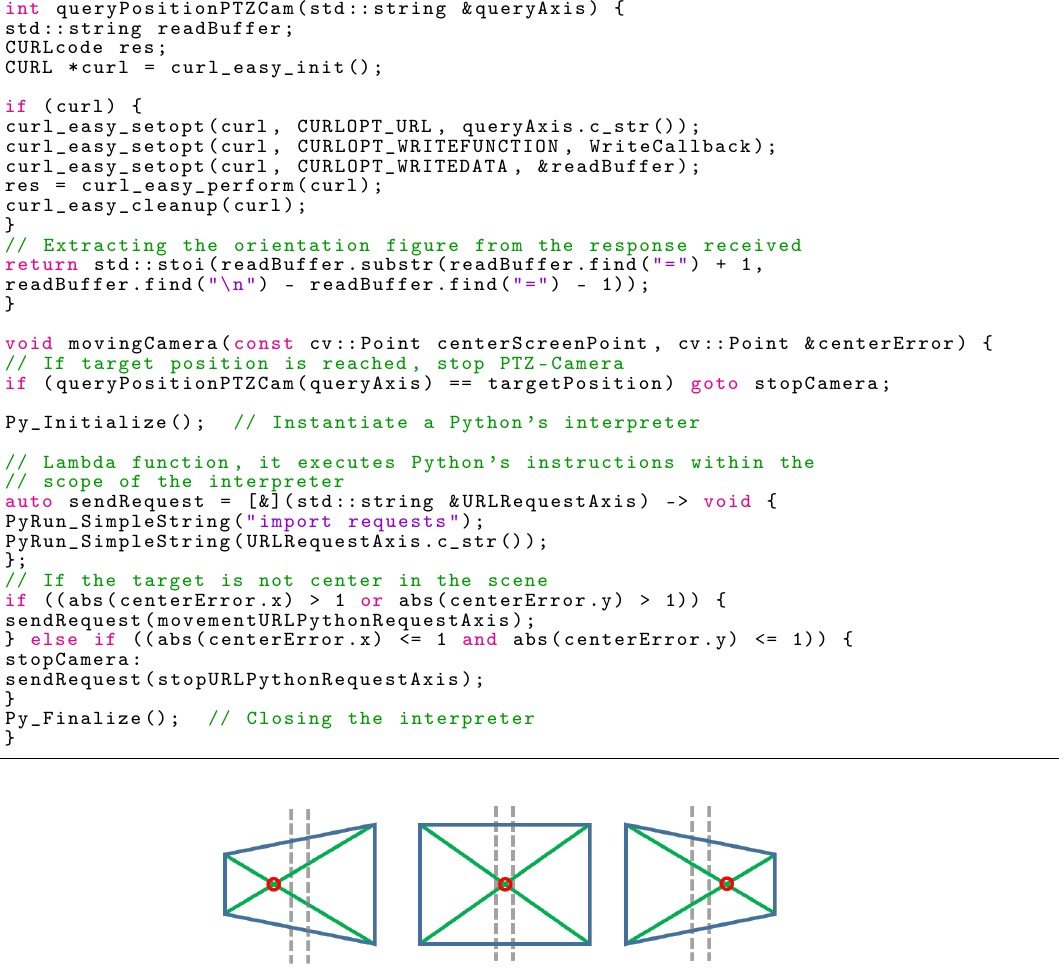
Figure 12. Use of the square-homography intersection to fix the orientation. The squares meaning